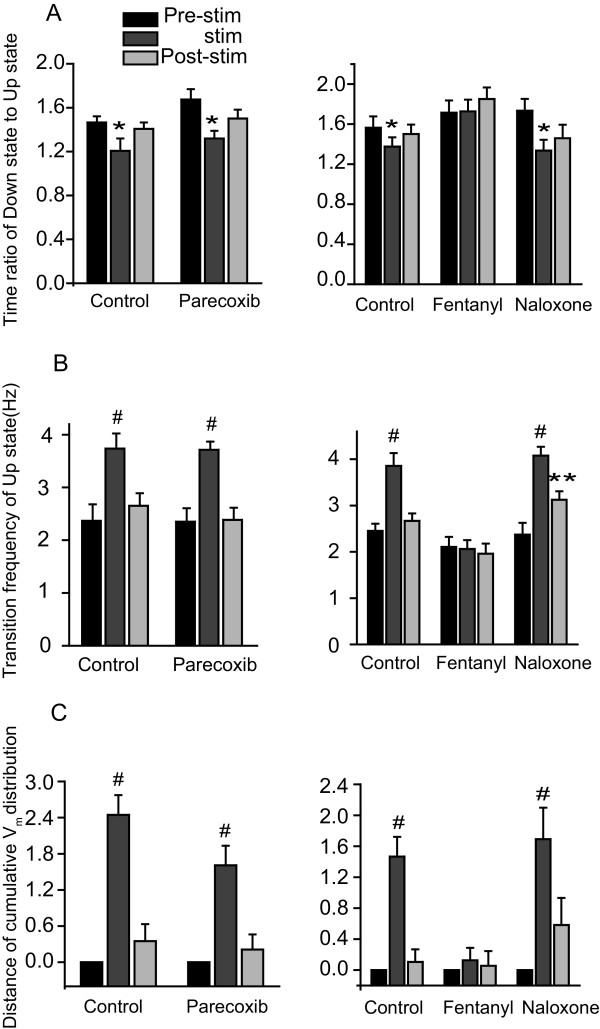
Group data for intracellular recordings at S1. The time ratio of Down state to Up state decreased (A, control), while transition frequency of Up state and the distance of cumulative Vmdistribution increased (B and C, control) in response to nociceptive stimulation. The response of all measures to nociceptive stimulation was not inhibited by parecoxib (left panels, n = 8). Fentanyl (right panels, n = 12) inhibited all responses and naloxone reversed fentanyl's action (n = 9). *P < 0.05, **P < 0.01, #P < 0.001.